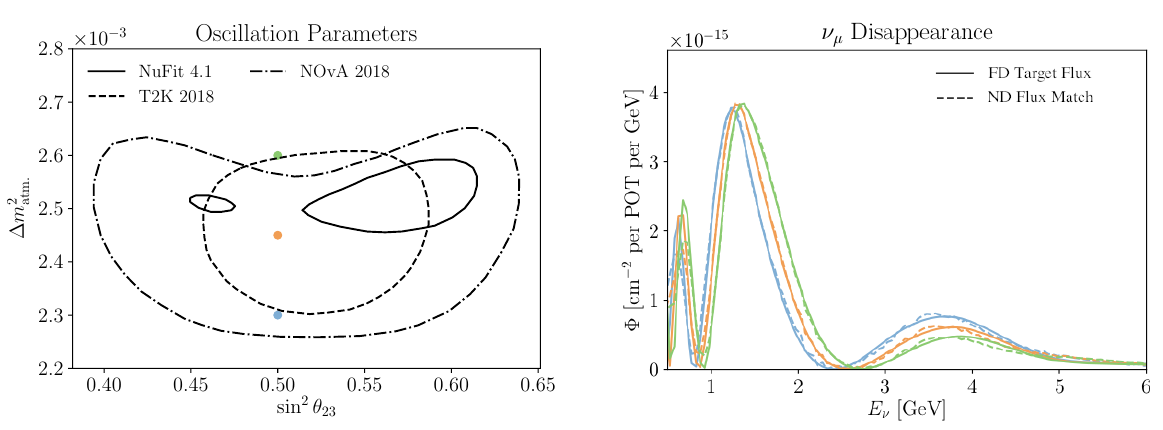
Figure 106. FD predicted muon neutrino spectra under a variety of oscillation hypotheses. Left: current best results for muon neutrino disappearance parameters, colors showing chosen oscillation hypotheses. Right: solid lines correspond to the FD oscillated flux predictions in color coordination with points on the left plot. The dashed lines are the best match spectra for oscillated FD fluxes constructed from linear combinations of ND fluxes (33 m off-axis + 280 kA special horn current